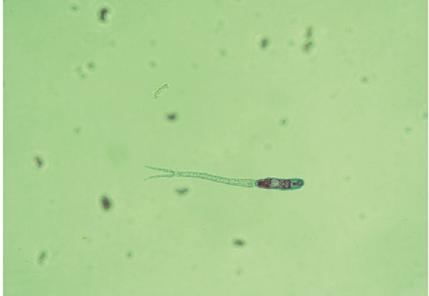
Figure 6: Image of cercariae taken from the